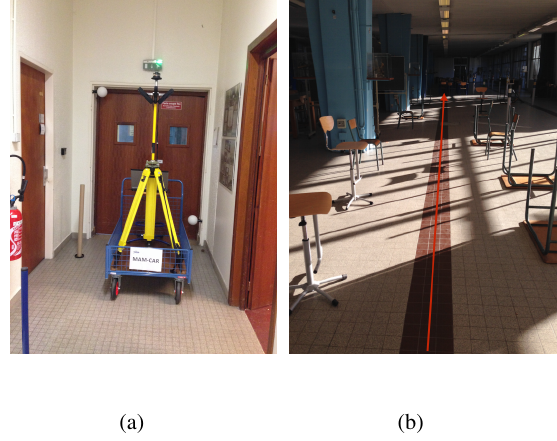
Figure 14: Mobile platform (a) and acquisition scene, with in red the path followed by our mobile system (b) the total station is indicated in blue dots. The final drift at the end is about 1.3 m after 20 meters of displacement. It is observed that the drift is constant during the movement. This result is already quite good if one considers that the proposed approach is incre- mental (at each new orthoimage only the current pose is updated without refining the previous poses).